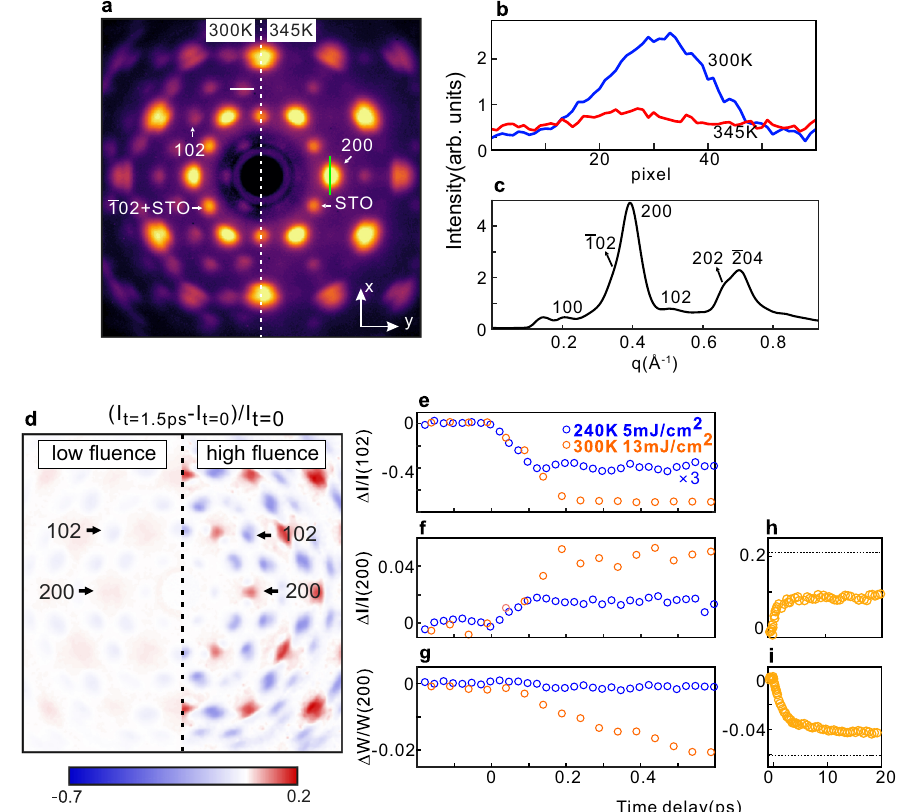
Fig. 2 | Ultrafast evolution of the diffraction spots in VO 2 . a Static electron diffraction patterns measured at 300K (left) and 345K (right) with the 3-MeV electrons in UED. Green line labels the direction where we trace the peak width. b Line pro fi le along the white line in a at 300K and 345K, respectively. c Azimuthallyaveragedintensityofthediffractionpatternat300K. d Imageplotof the intensity difference between the diffraction patterns at t =1.5ps after